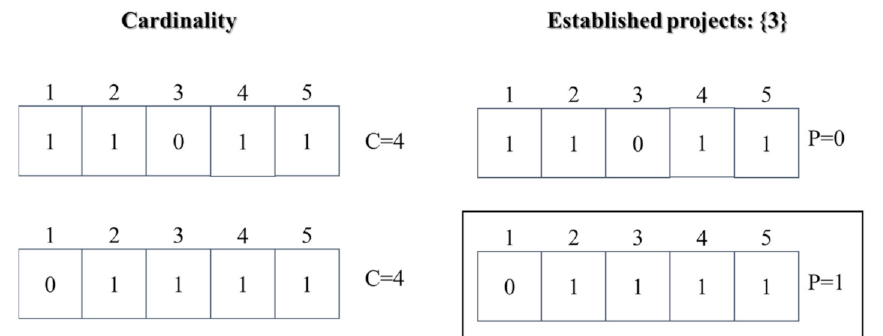
Figure 7. Solutions evaluated in different